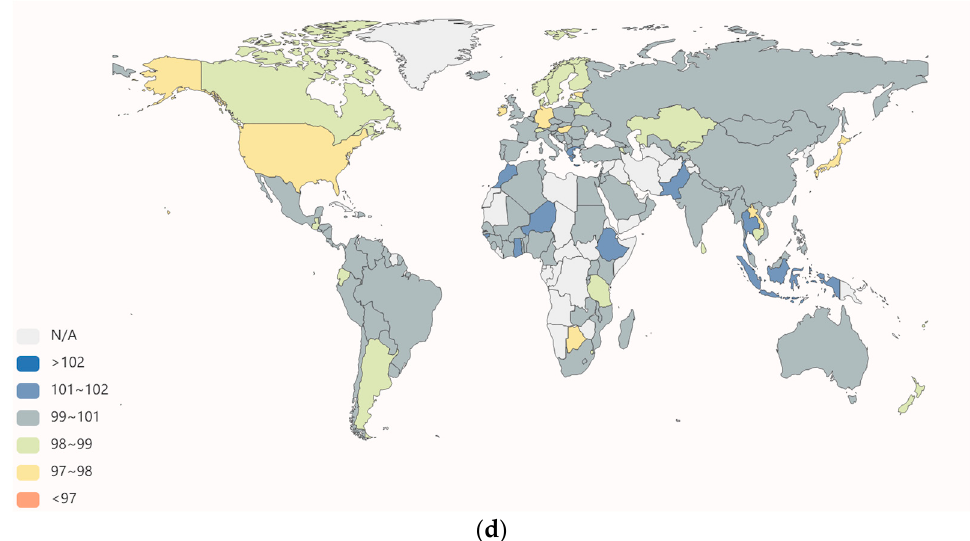
Figure 4. Spatial variation of the globalization index and globalization barometer in 2020. ( a ) Spatial variations of de facto globalization. ( b ) Spatial variations of de facto globalization barometer. ( c ) Spatial variations of de jure globalization. ( d ) Spatial variations of de jure globalization barometer.